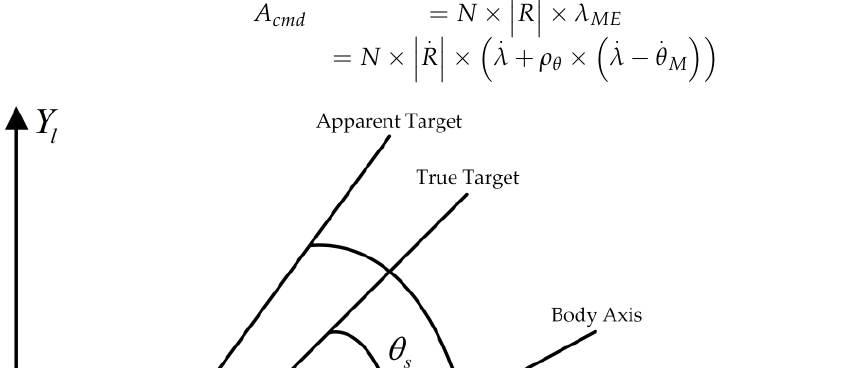
(9) Figure 4. Engagement kinematics between the missile and target.